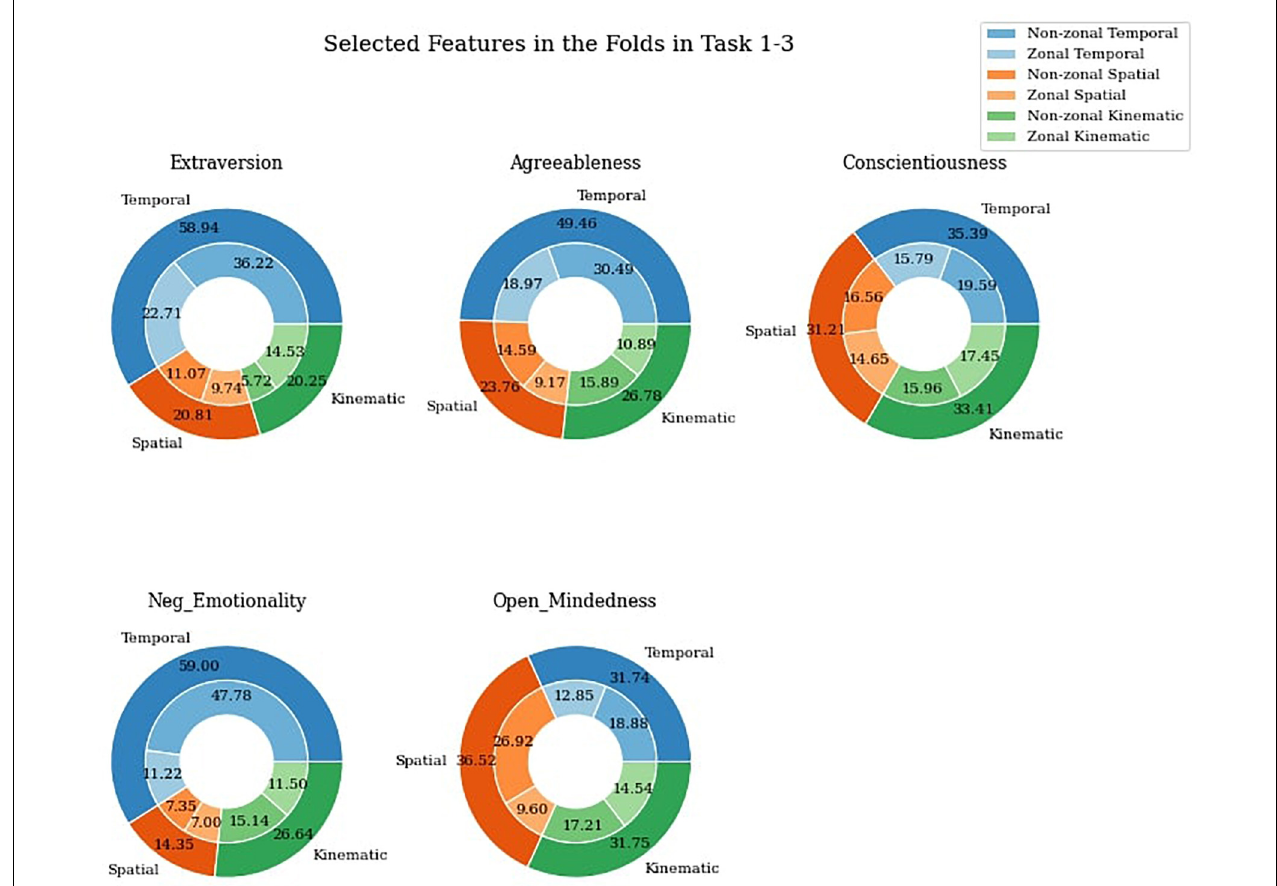
FIGURE 8 | Selected temporal, spatial, and kinematic features between